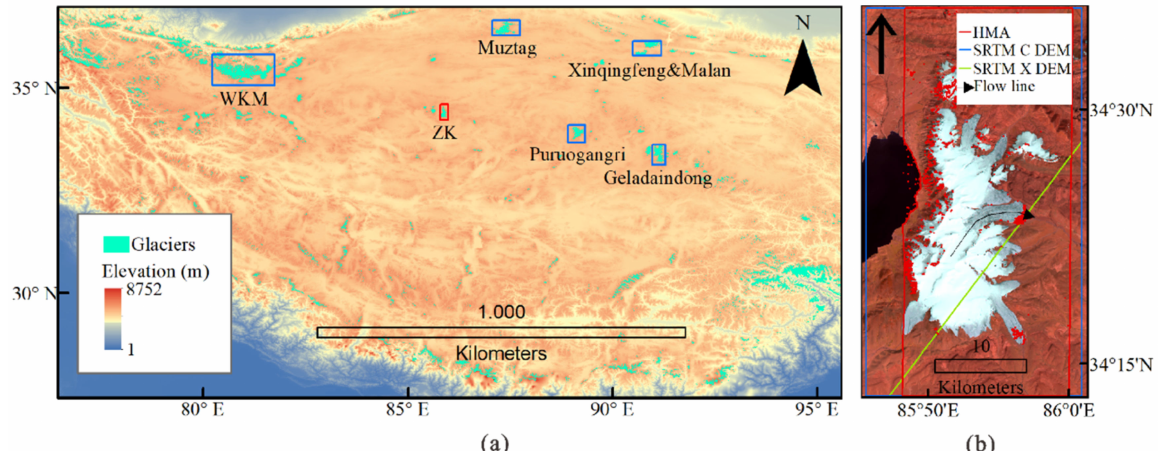
Figure 1. ( a ) Map of the Tibetan Plateau (TP). The red square marks our study site and blue squares for other surging regions among the Central and Northern TP; ( b ) glaciers in Zangser Kangri (ZK) and coverages of digital elevation models (DEMs). The Shuttle Radar Topography Mission C-band DEM (SRTM C DEM) covers the whole map while the Shuttle Radar Topography Mission X-band DEM SRTM X DEM does not cover the lower right part due to the narrower swath width. High Mountain Asia 8-meter DEM (HMA) has thin meridional coverage and shows many voids, especially on glacier edges (detailed information about voids can be found in Figure A2). The line with an arrow indicated the nominal flow line used for velocity extraction in later